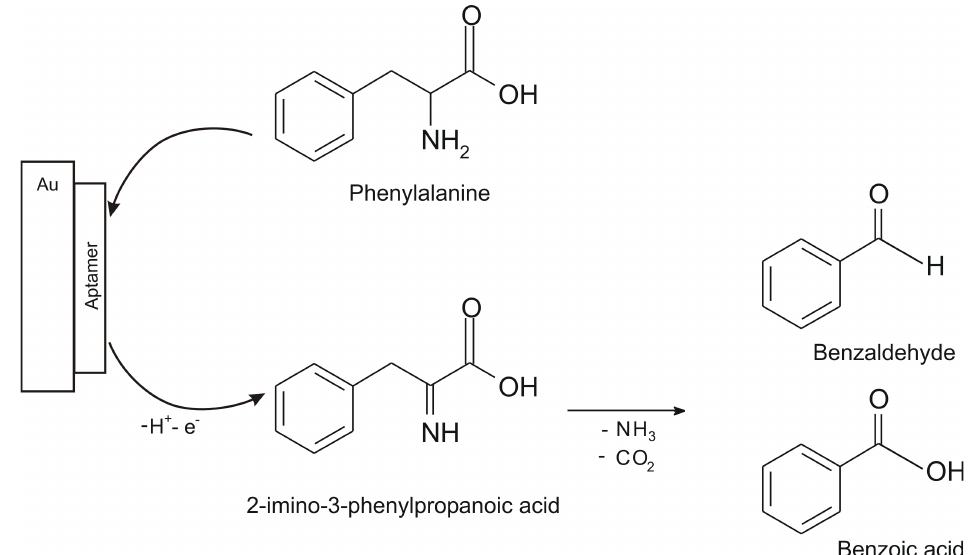
Figure 8. Biosensor detection mechanism [65].